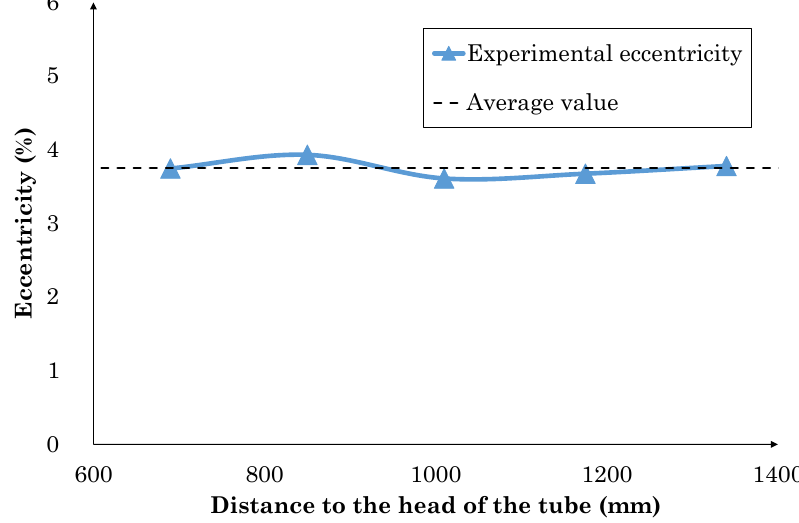
Figure 4. Experimental measure of wall thickness